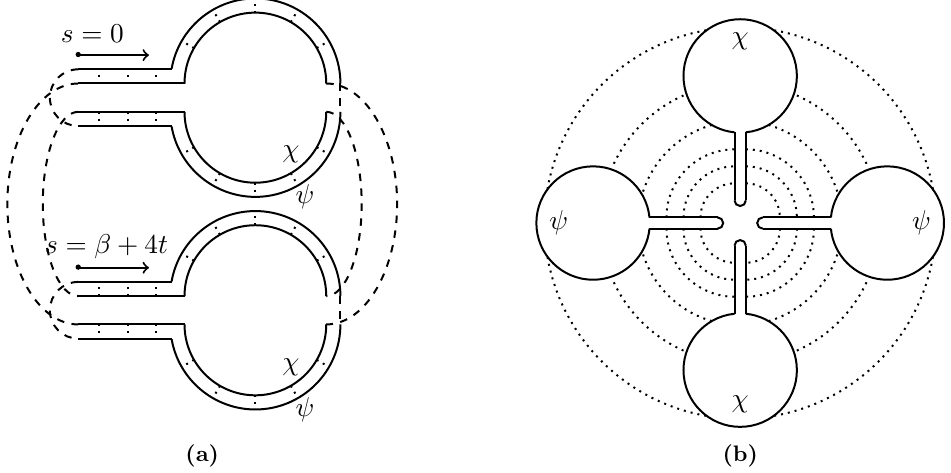
Figure 2. Two equivalent illustrations of the contour C of path integral for computing the second R(cid:19)enyi